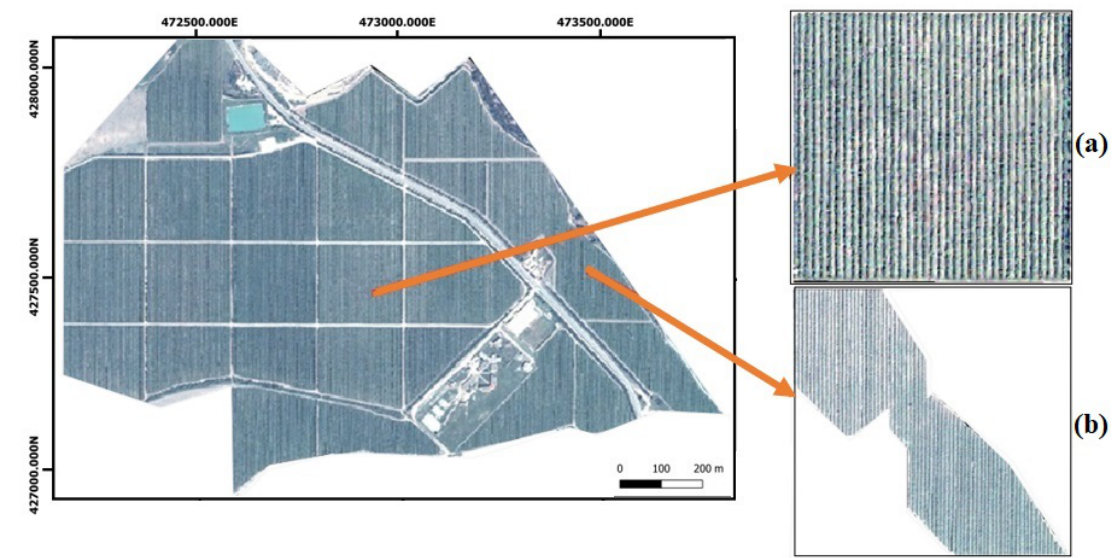
Figure 3. The false color (R,G,B,NIR) of the OUARGHA orchard obtained by the Mohammed VI satellite in (23 July 2020). ( a , b ) two examples of parcels. Projected Coordinate System: EPSG:26191—Merchich/Nord Maroc; Projection: Transverse Mercator; Linear Unit: Meter; Datum: Merchich; Prime Meridian: Greenwich; Angular Unit: Degree.